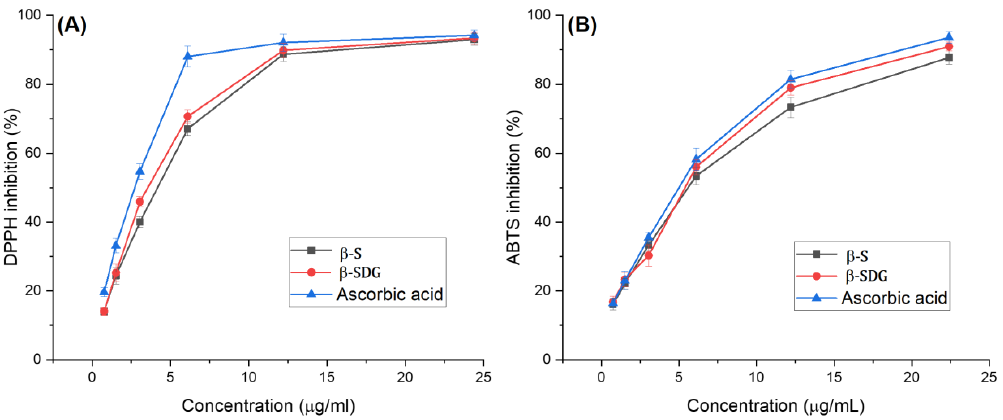
Figure 1. Antioxidant activity assessments of isolated compounds in terms of DPPH ( A ) and ABTS ( B ) radical scavenging activities.